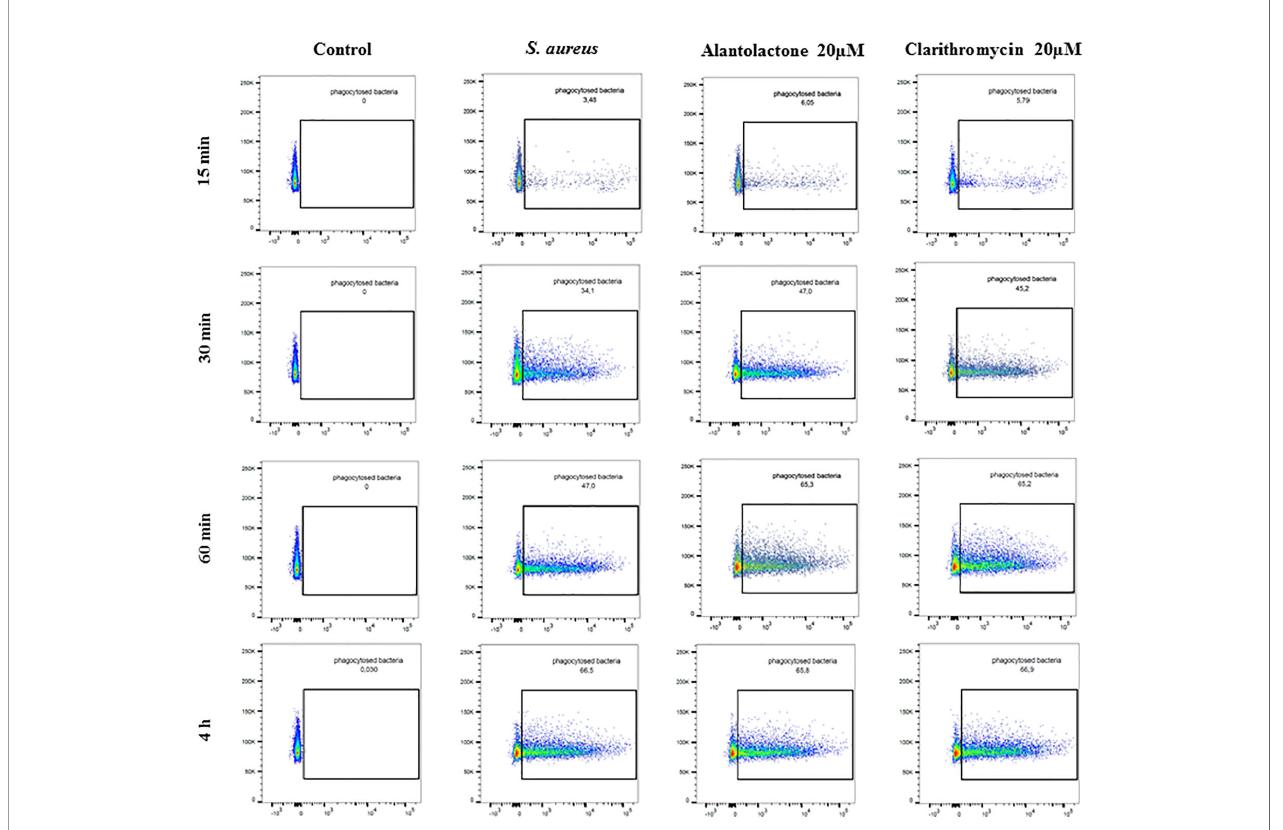
FIGURE 3 | The in fl uence of alantolactone on S. aureus uptake by THP-1 cells at different time-points (15, 30, 60 min, and 4 h). Data show representative cytograms obtained at different time-points (15, 30, 60 min, and 4